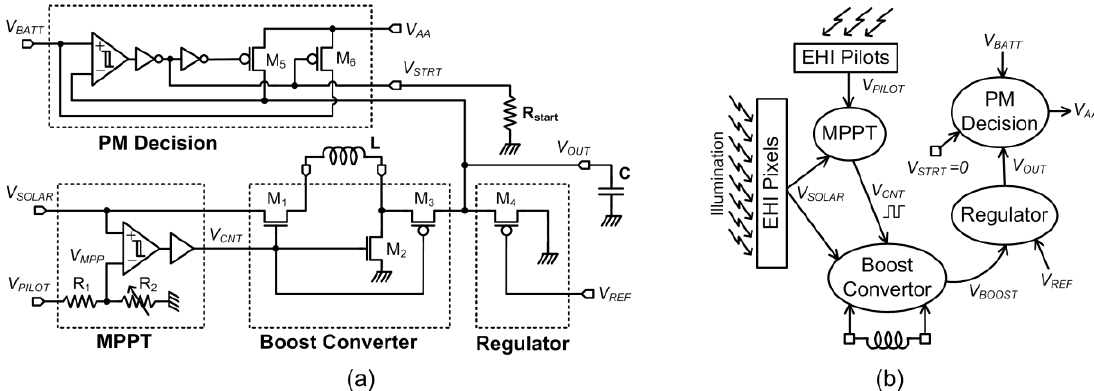
Figure 7. ( a ) Circuit diagram of the power management system (PMS); ( b ) operation principle of the